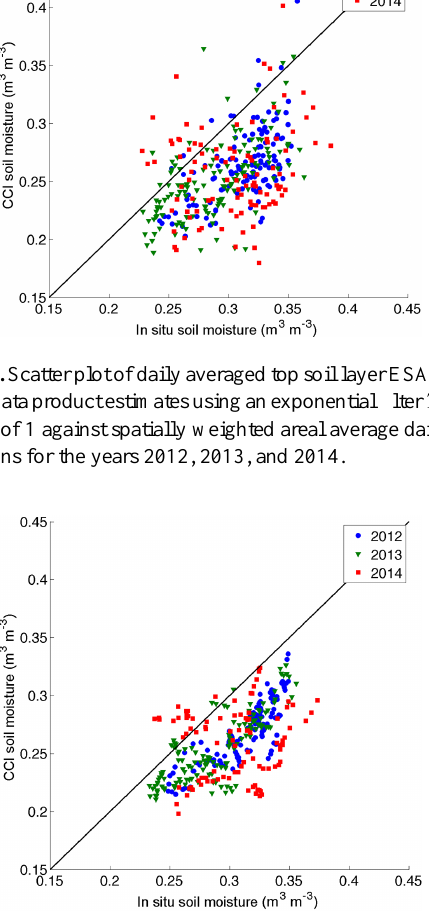
Figure 11. Scatter plot of daily averaged top soil layer ESA CCI soil moisture data product estimates using an exponential filter T pa- rameter value of 3.5 against spatially weighted areal average daily in situ observations for the years 2012, 2013, and 2014.